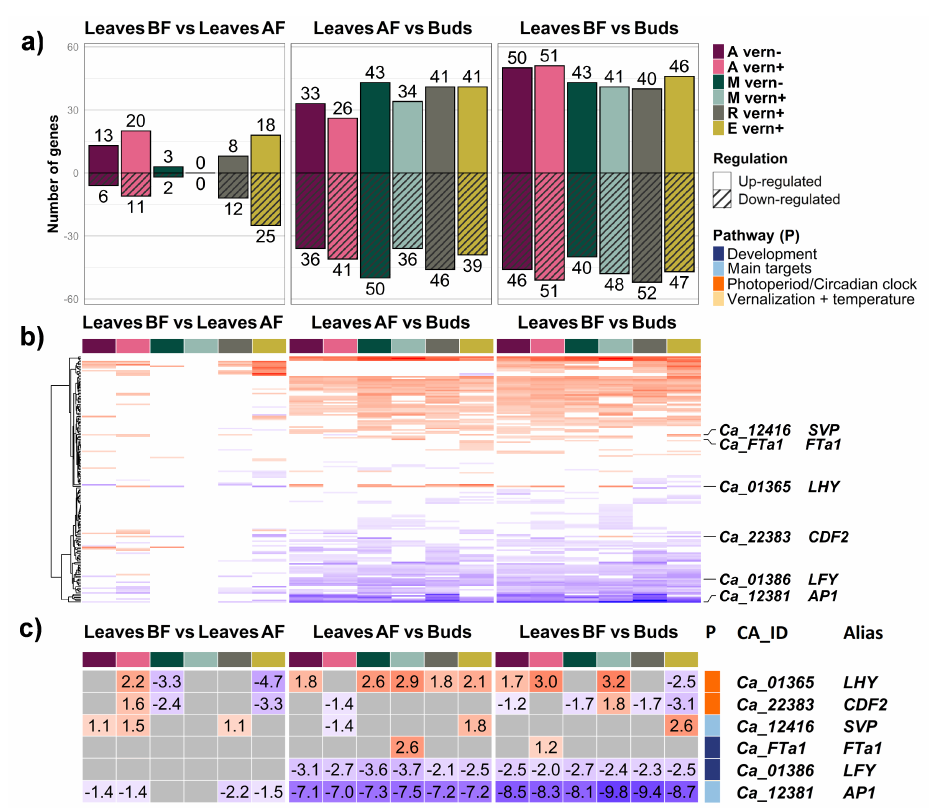
Figure 2. Differential expression of flowering time genes in comparisons between tissue types. ( a ) Number of flowering time genes differentially expressed between three tissue types. Each comparison was analyzed for the following species/accessions and conditions: ‘A’— C. arietinum , ‘M’—ICCV 96029 mutant, ‘R’— C. reticulatum , ‘E’— C. echinospermum , ‘vern+’—after vernalization, and ‘vern-’—without vernalization. ( b ) The direction of gene expression regulation did not change with respect to species/accessions or conditions. The rows of the heatmap visualize the values of the log2 fold change (FC) for the expression of all genes in the dataset between three tissue types. It is evident that the color in each row (corresponding to individual genes) does not change between the columns (corresponding to species/accessions and conditions) within each comparison. FC values for three genes, which do not follow this rule (the orthologs of LHY , CDF2 , and SVP ) are shown in panel ( c ). ( c ) The heatmap shows the FC values for differential expression of the genes listed in the right-hand panel. Up- and downregulation are shown in red and blue, respectively. Gray cells indicate the absence of differential expression between tissue